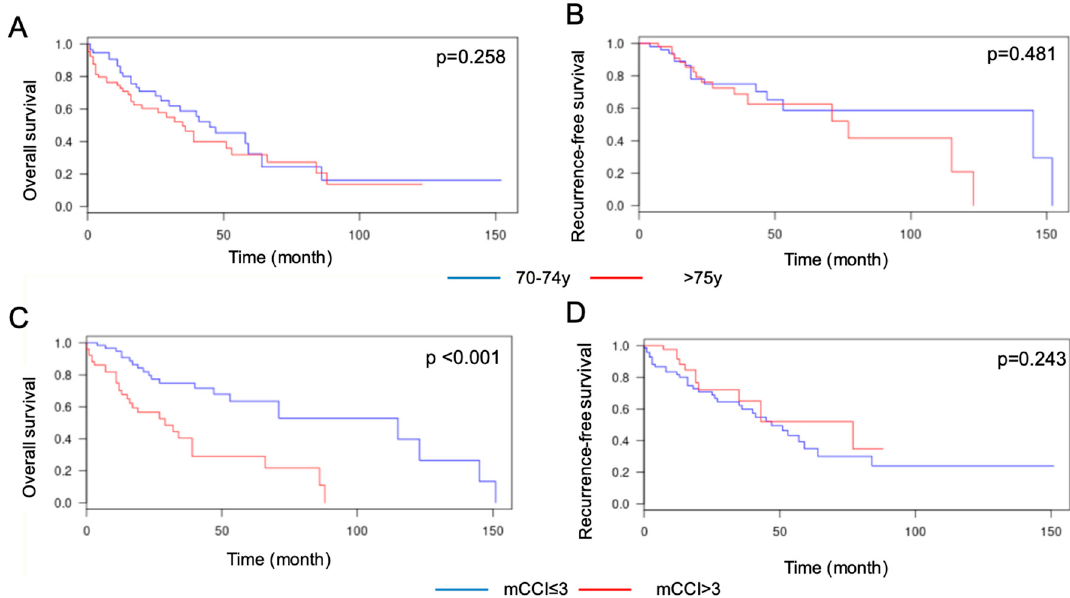
Figure 1. Kaplan–Meier curves estimating overall and recurrence-free survival by age and modified Charlson Comorbidity Index (mCCI) score; ( A ) overall survival by age; ( B ) recurrence-free survival by age; ( C ) overall survival by mCCI score; ( D ) recurrence-free survival by mCCI score.